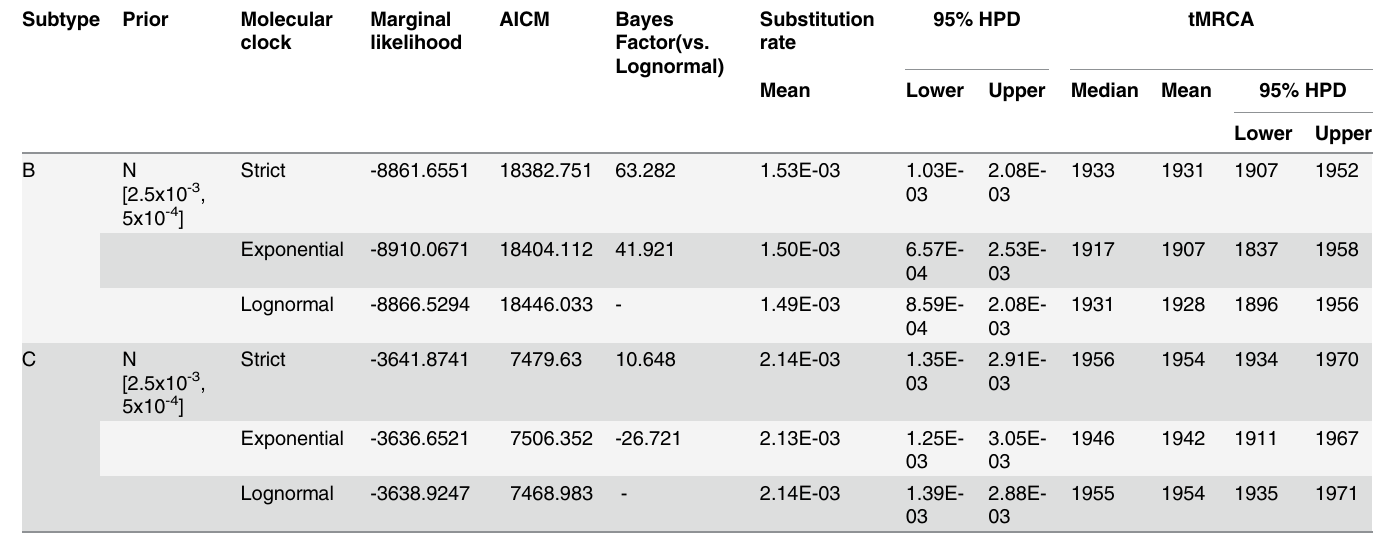
Table 1. Substitution rates and time of the most recent common ancestors (tMRCAs) of subtypes B and C for all tested molecular clock